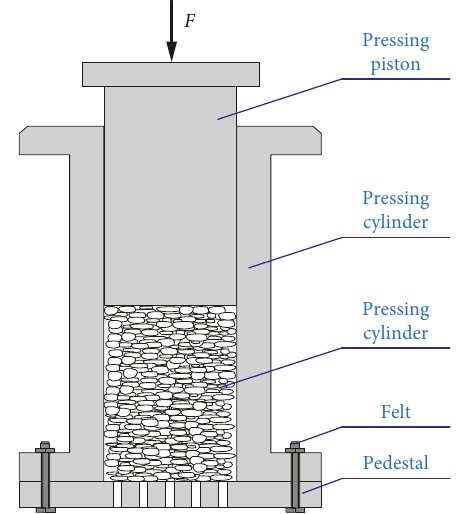
Figure 2: Preparation device for tested specimen.